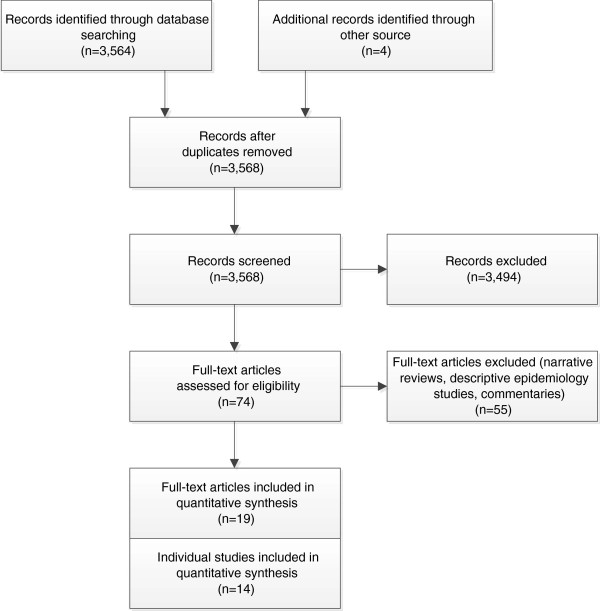
PRISMA flow diagram.